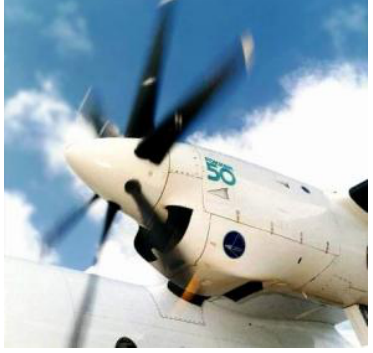
Figure 4 – View on turbo-prop engine (Fokker 50